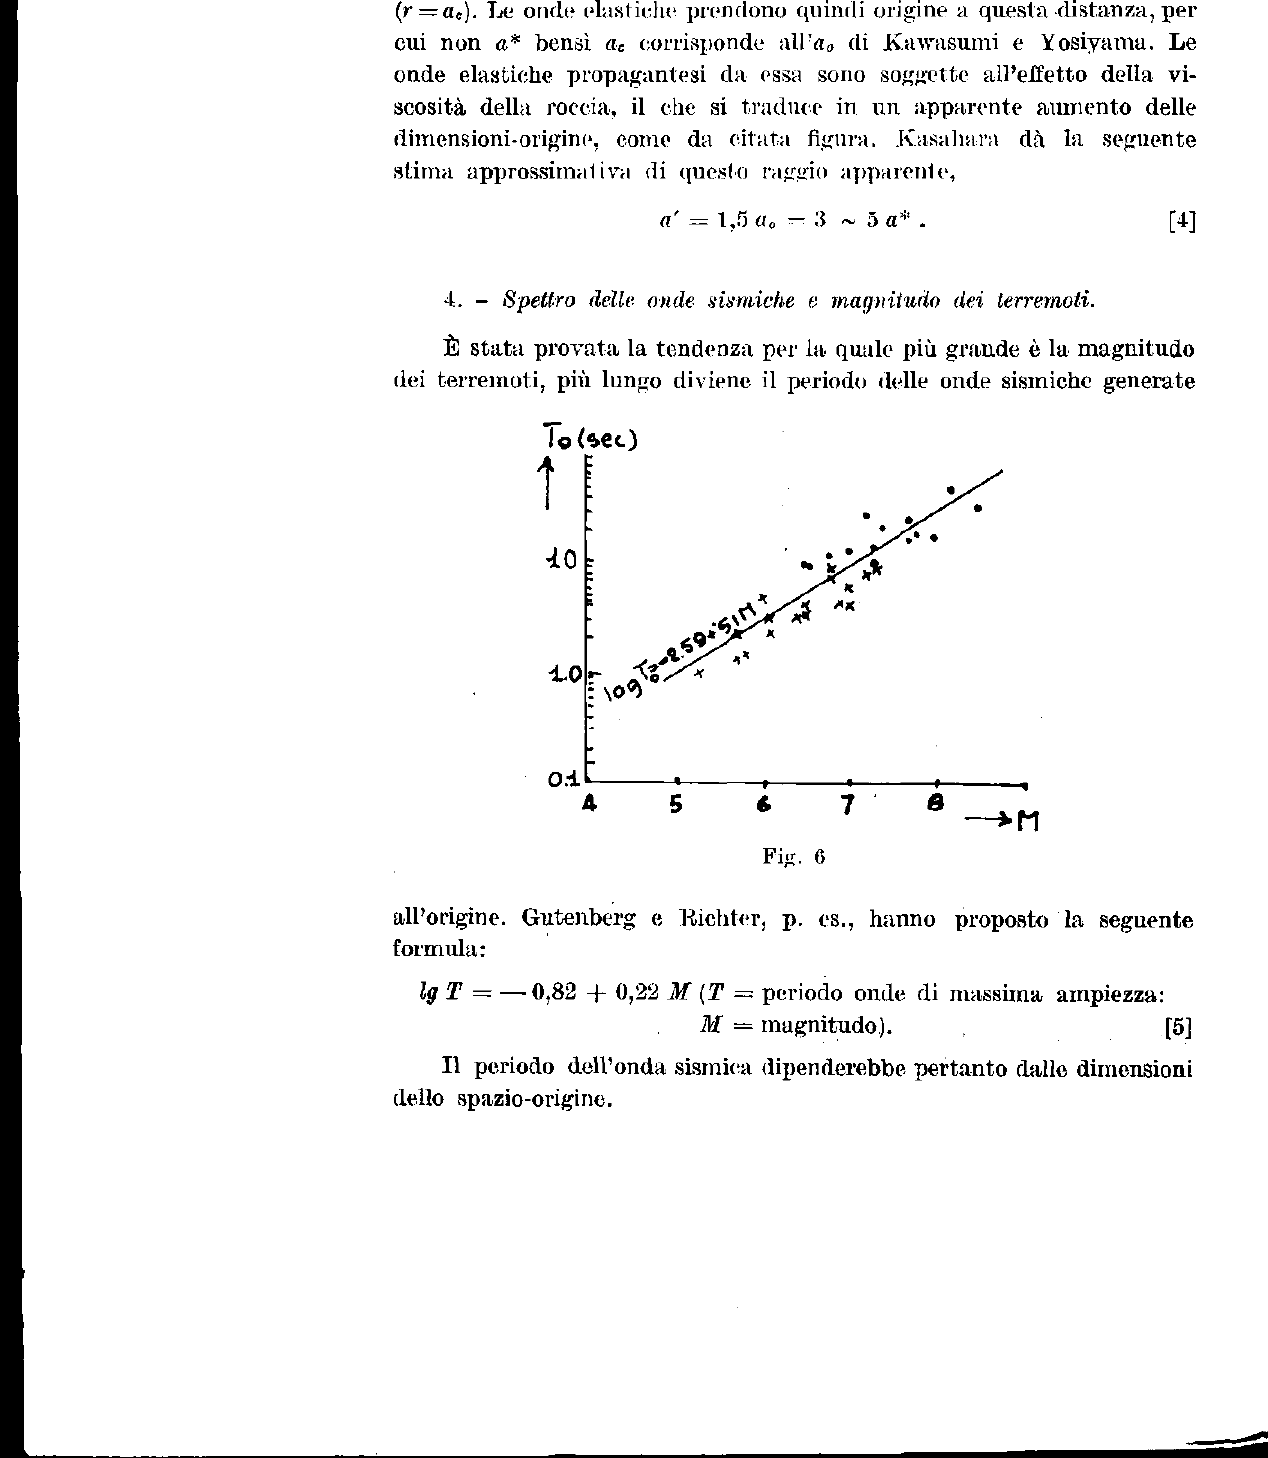
figura. Kasahara dà la